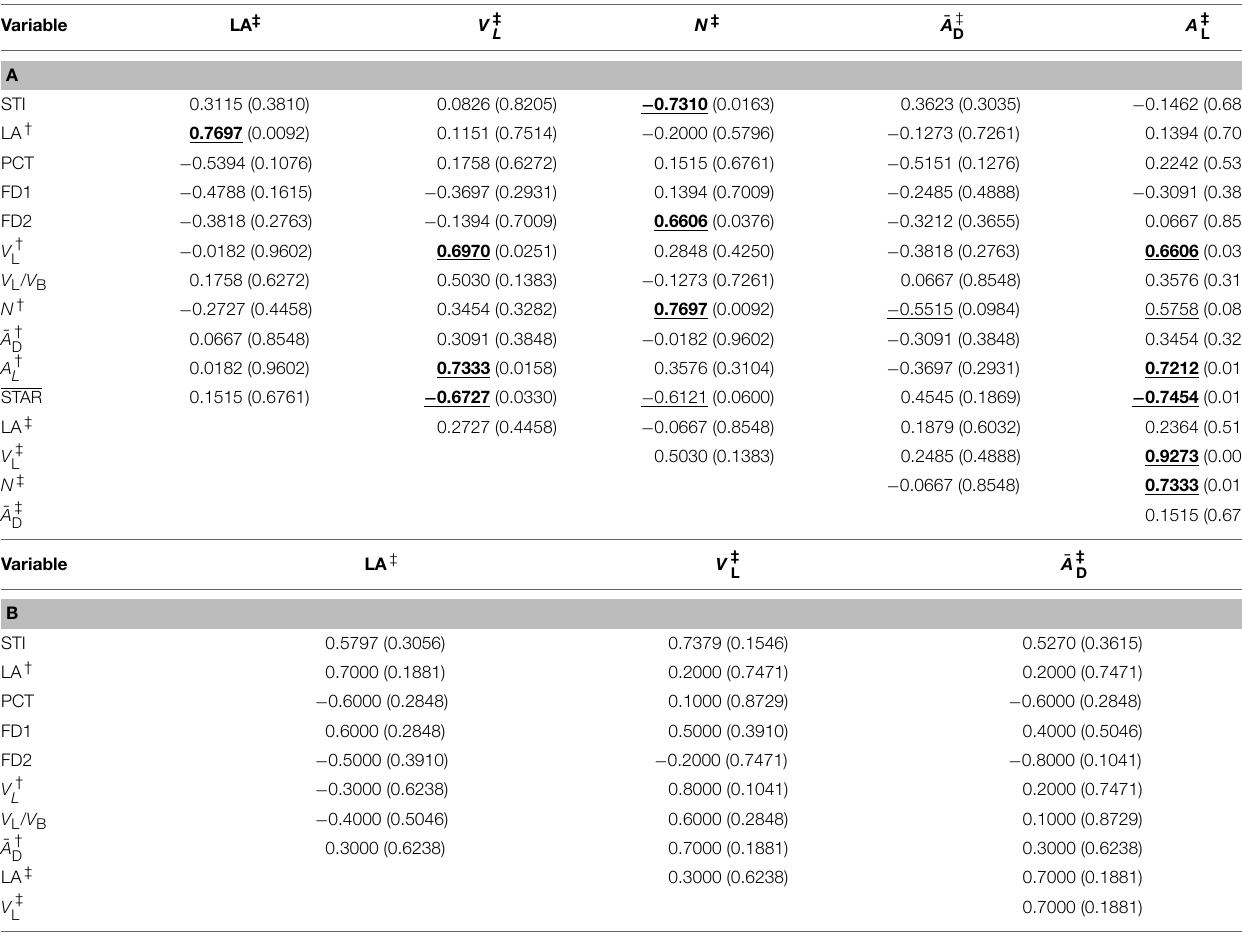
TABLE 5 | Spearman’s rank-based correlation coefficients (with probabilities of significance below, in parentheses) between the shade tolerance index and crown traits measured from CT scanning data and CT images appropriately processed, by group depending on leaf type ( a ) needlelike ( n = 10 ) and ( b ) scalelike ( n = 5 ); the correlations statistically significant at 5% are bolded and underlined; those only significant at 10% are simply underlined.